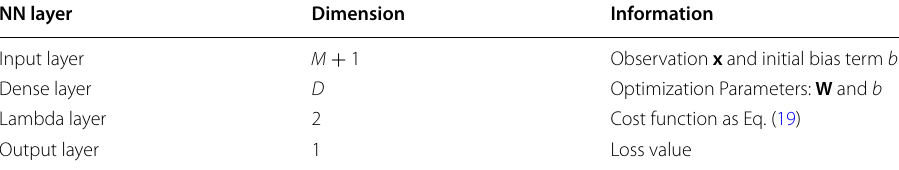
Table 1 The relation between the neural network and separation process NN layer Dimension Information 1 Observation x and initial bias term b Input layer M + Dense layer D Optimization Parameters: W and b Lambda layer 2 Cost function as Eq. (19) Output layer 1 Loss